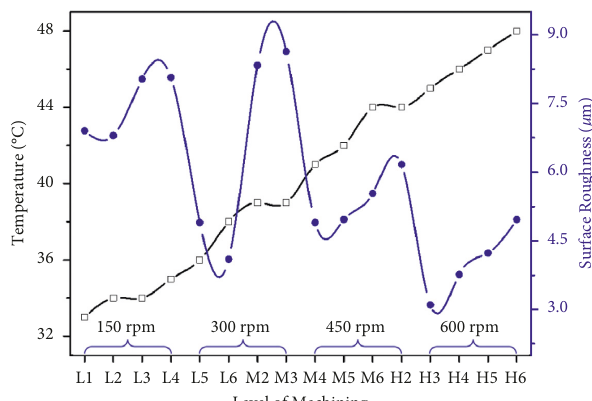
Figure 6: Surface roughness and temperatures at different levels of cutting speed in wet machining with boric acid.